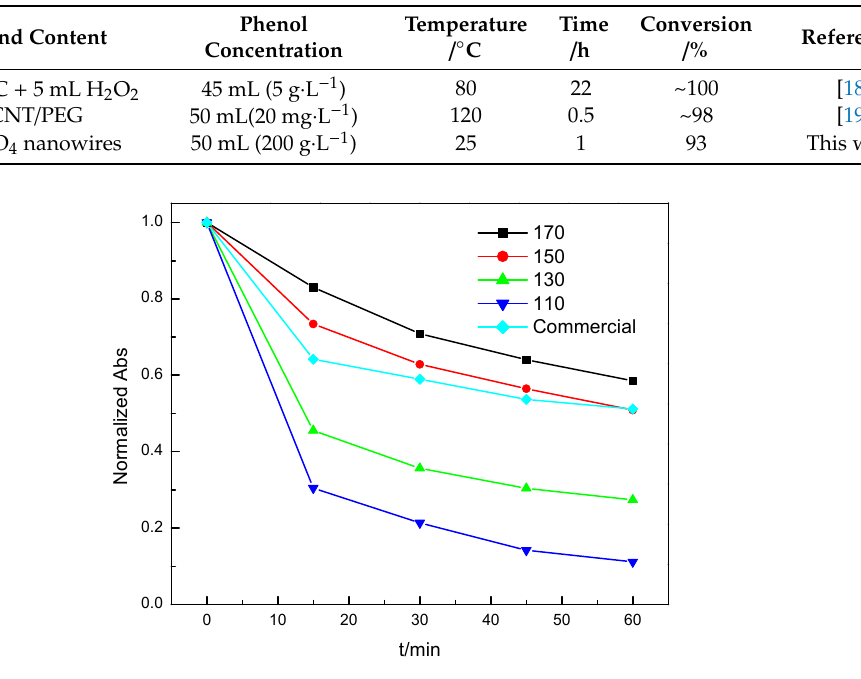
Figure 4. E ff ect of pH on the performance of Mn 3 O 4 . Figure 3. Effect of preparation temperature on the performance of Mn 3 O 4 (From top to bottom: 170; 150; 130; 110 °C and commercial Mn 3 O 4 ).